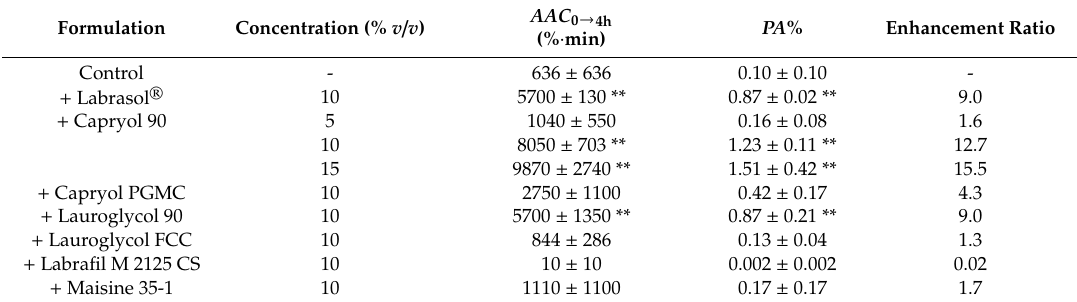
Figure 1. The effects of Labrasol ® and its related formulations on plasma concentrations of glucose after small intestinal administration of insulin (80 IU/kg) using an in situ closed loop. Glucose concentrations are expressed as a percentage of the initial concentration at time zero. Each value represents the mean ± standard error (S.E.) of three to four rats. Table 2. Effects of various formulations on the small intestinal absorption of insulin.